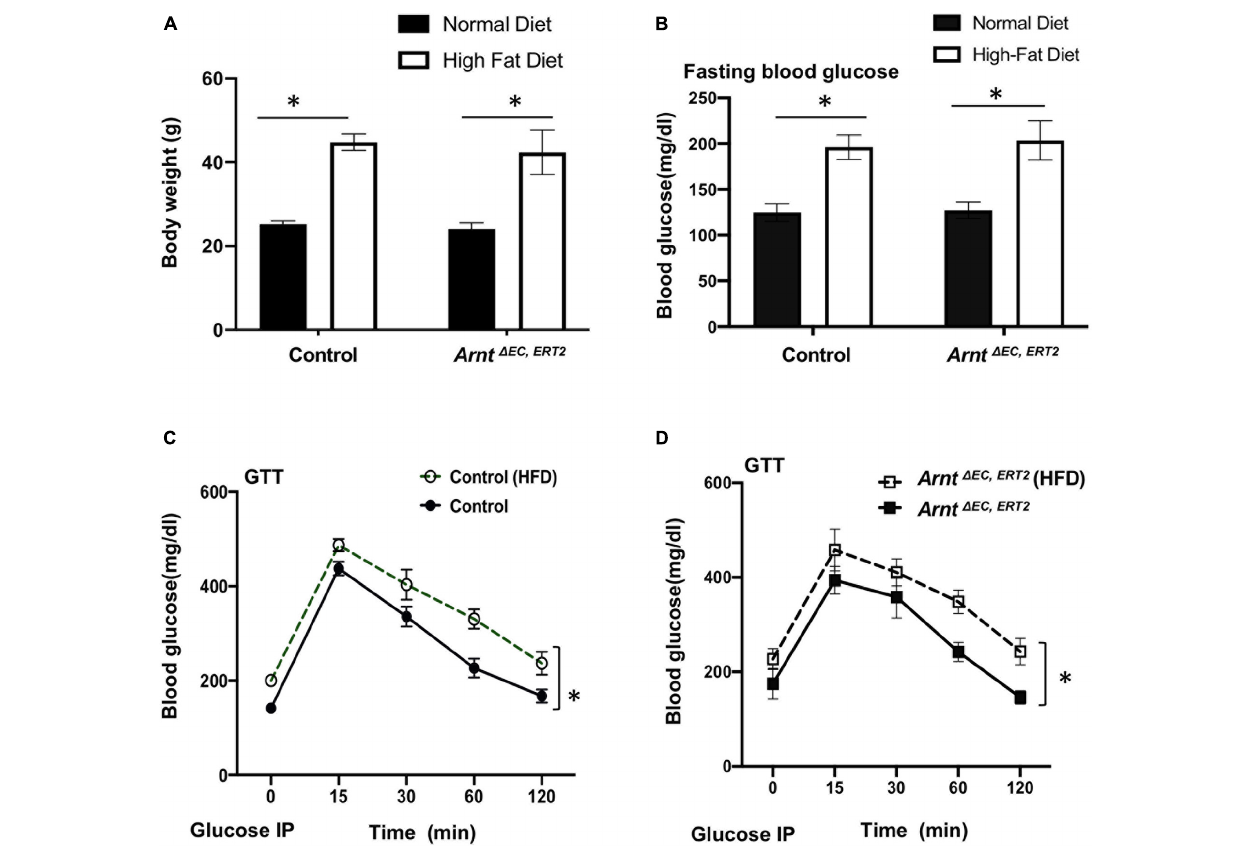
FIGURE 2 | High-fat diet (HFD) induced type-2 diabetic model in both WT control and Arnt (cid:49) EC , ERT2 mice. (A) Bodyweight in control and Arnt (cid:49) EC , ERT2 mice placed on both a standard diet and HFD for 8 weeks as indicated. (B) Fasting plasma glucose level in control and Arnt (cid:49) EC , ERT2 mice after 8 weeks of standard diet and HFD for as indicated. (C,D) Glucose tolerance test (GTT) of control and Arnt (cid:49) EC , ERT2 mice after 8 weeks of standard diet and HFD for as indicated. Glucose was administered as a 0.2 g/ml/100 g IP injection. Data are presented as the mean ± SEM ( n = 5–8) mice per group. ∗ P < 0.05, ∗∗ P < 0.01 versus control